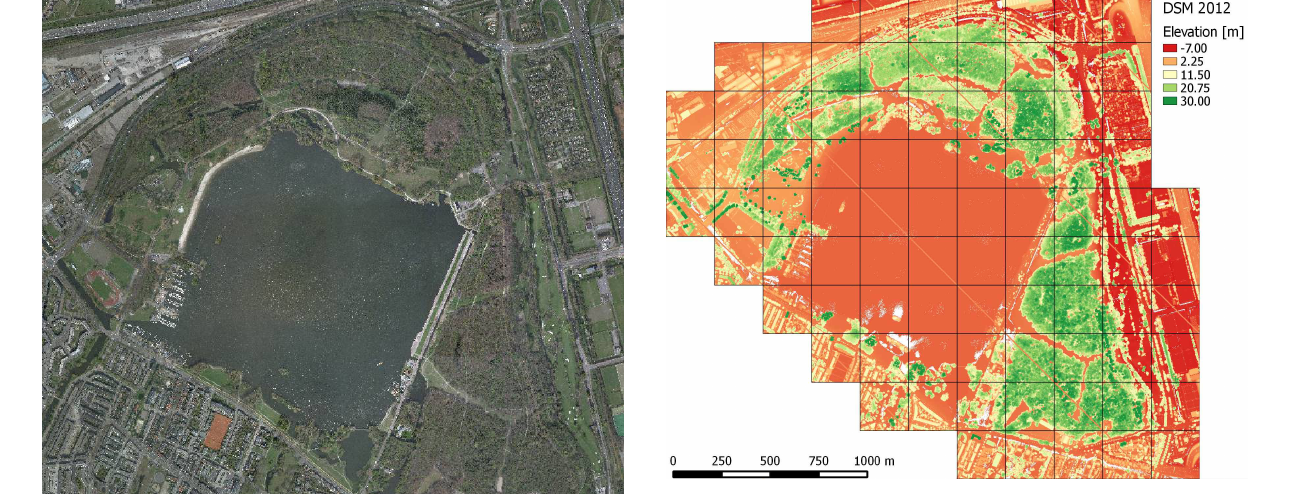
Figure 2: Digital surface model showing the elevations in the Kralingse Bos in the year 2012 classification. The process is therefore divided into three compo-